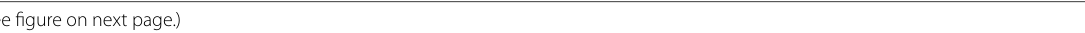
Fig. 17 Bivariate plots of conch parameters and septal spacing (of the last half volution) in the family Prionoceratidae (grey background dots represent the entire sample). A , D , G , J , M Conch width index (ww/dm) and septal spaces. B , E , H , K , N Whorl width index (ww/wh) and septal spaces. C , F , I , L , O Whorl expansion rate (WER) and septal spaces. A – C All representatives. D – F Late Tournaisian assemblage. G – I Early Tournaisian assemblage. J – L Late Famennian assemblage. M – O Middle